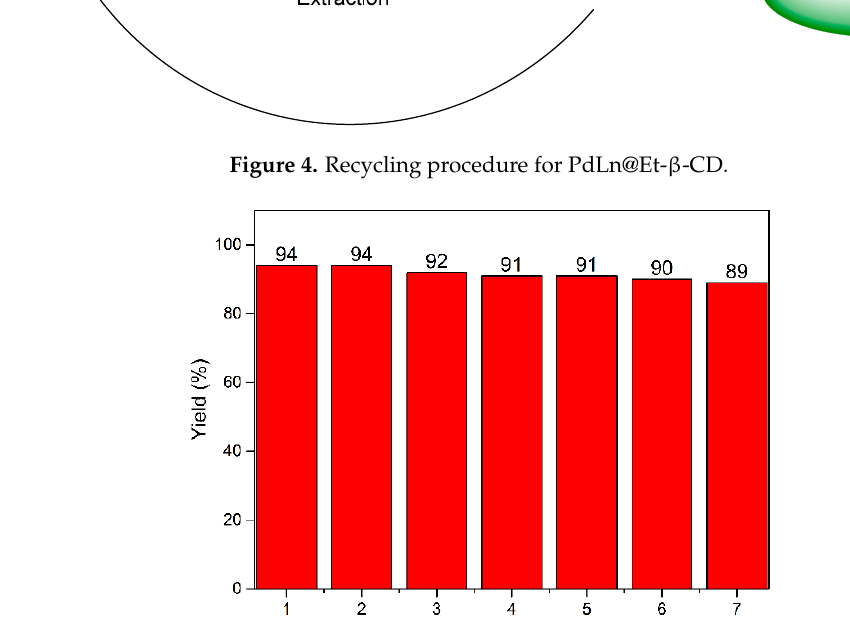
Figure 5 . Recycling of PdLn@Et ‐β‐ CD.